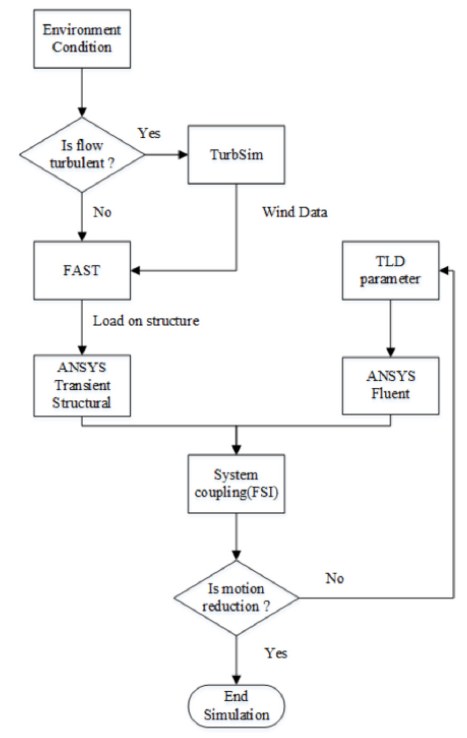
Figure 4. The flow chart of the simuation performed in this study.